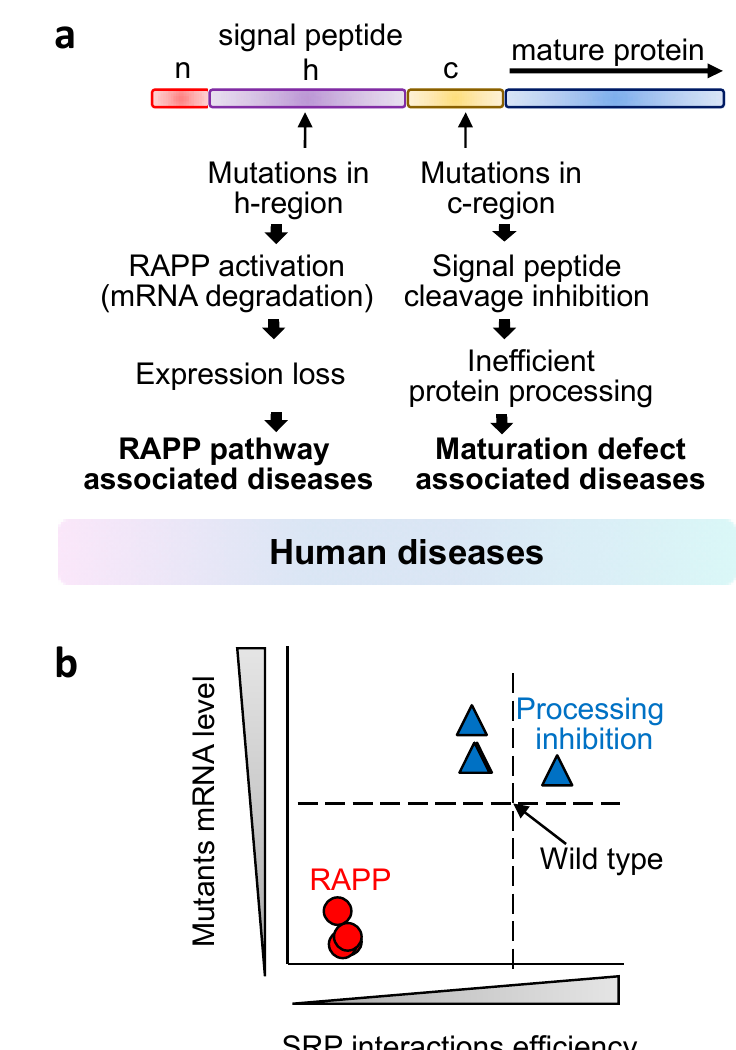
Figure 4. Mutations in signal sequences and human diseases. ( a ) Locations of mutations in the signal sequences and possible molecular mechanisms of human diseases. ( b ) Graph representation of the effects of the mutations in signal sequences on the mRNA level (mRNA stability) and on SRP – nascent chain interactions. When a mutation is located in h-region of a signal peptide and affects its hydrophobic properties, it leads to the loss of interactions with SRP and decrease of mRNA level by the triggering the RAPP pathway activation (red circles). The outcome of this pathway is a degradation of mRNAs of defective secretory proteins. If a mutation is located in the c-region of a signal peptide and does not inhibit interaction with SRP and does not lead to mRNA degradation (blue triangles) it may affect maturation of the protein due to the failure of signal sequence cleavage by signal peptidase. Please note that a benign mutation (natural polymorphism) not associated with a disease will show a similar plot.